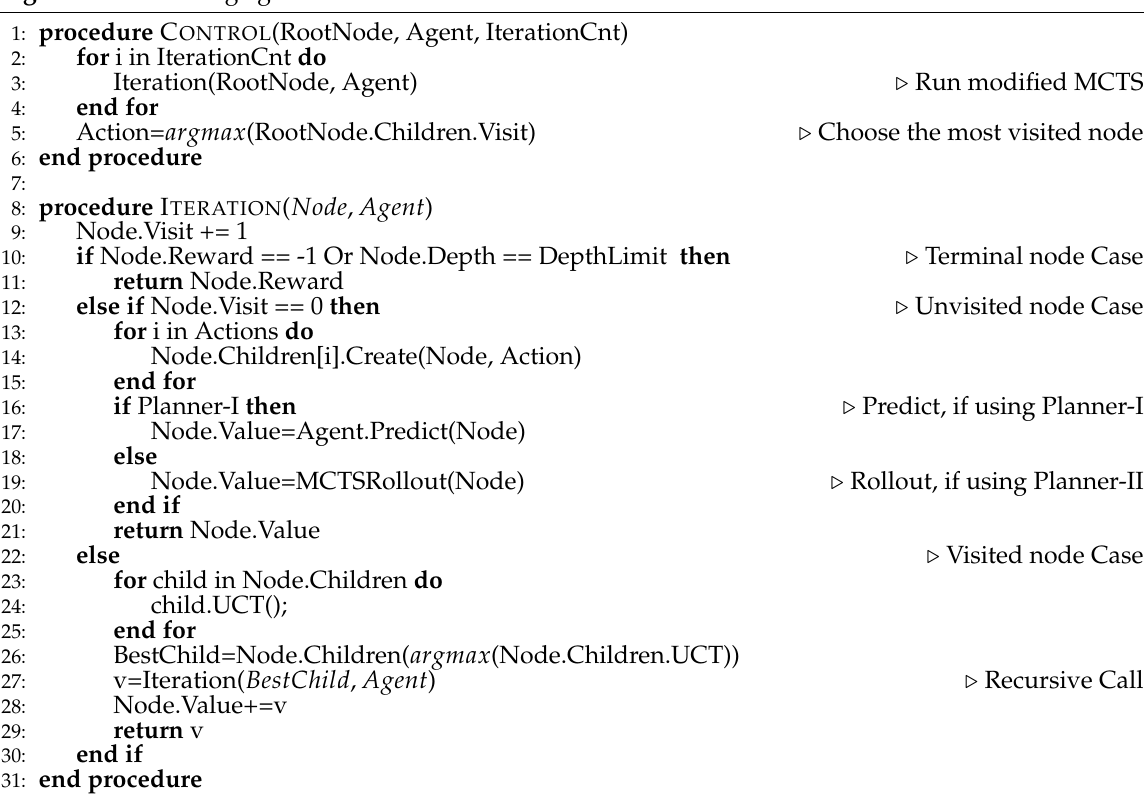
Algorithm 1 Planning agent-based control.